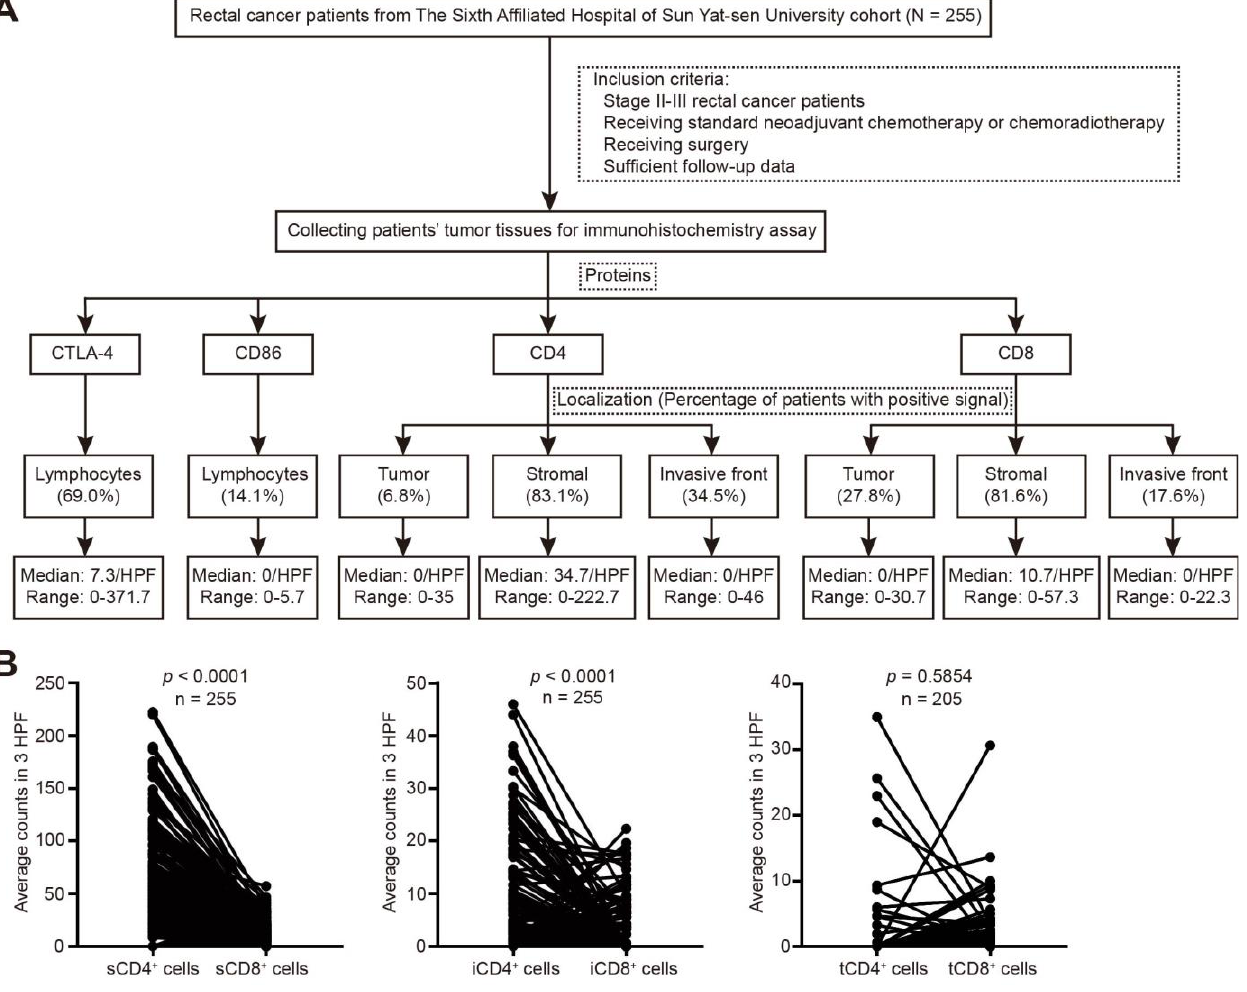
Figure 2. Expression of CTLA-4, CD86, CD4, and CD8 in rectal cancer after nCRT. ( A ) Schematics showing the workflow for detecting and quantifying the expression of immune-related molecules. ( B ) Paired t test was performed between s/t/iCD4 + and s/t/iCD8 + cells.